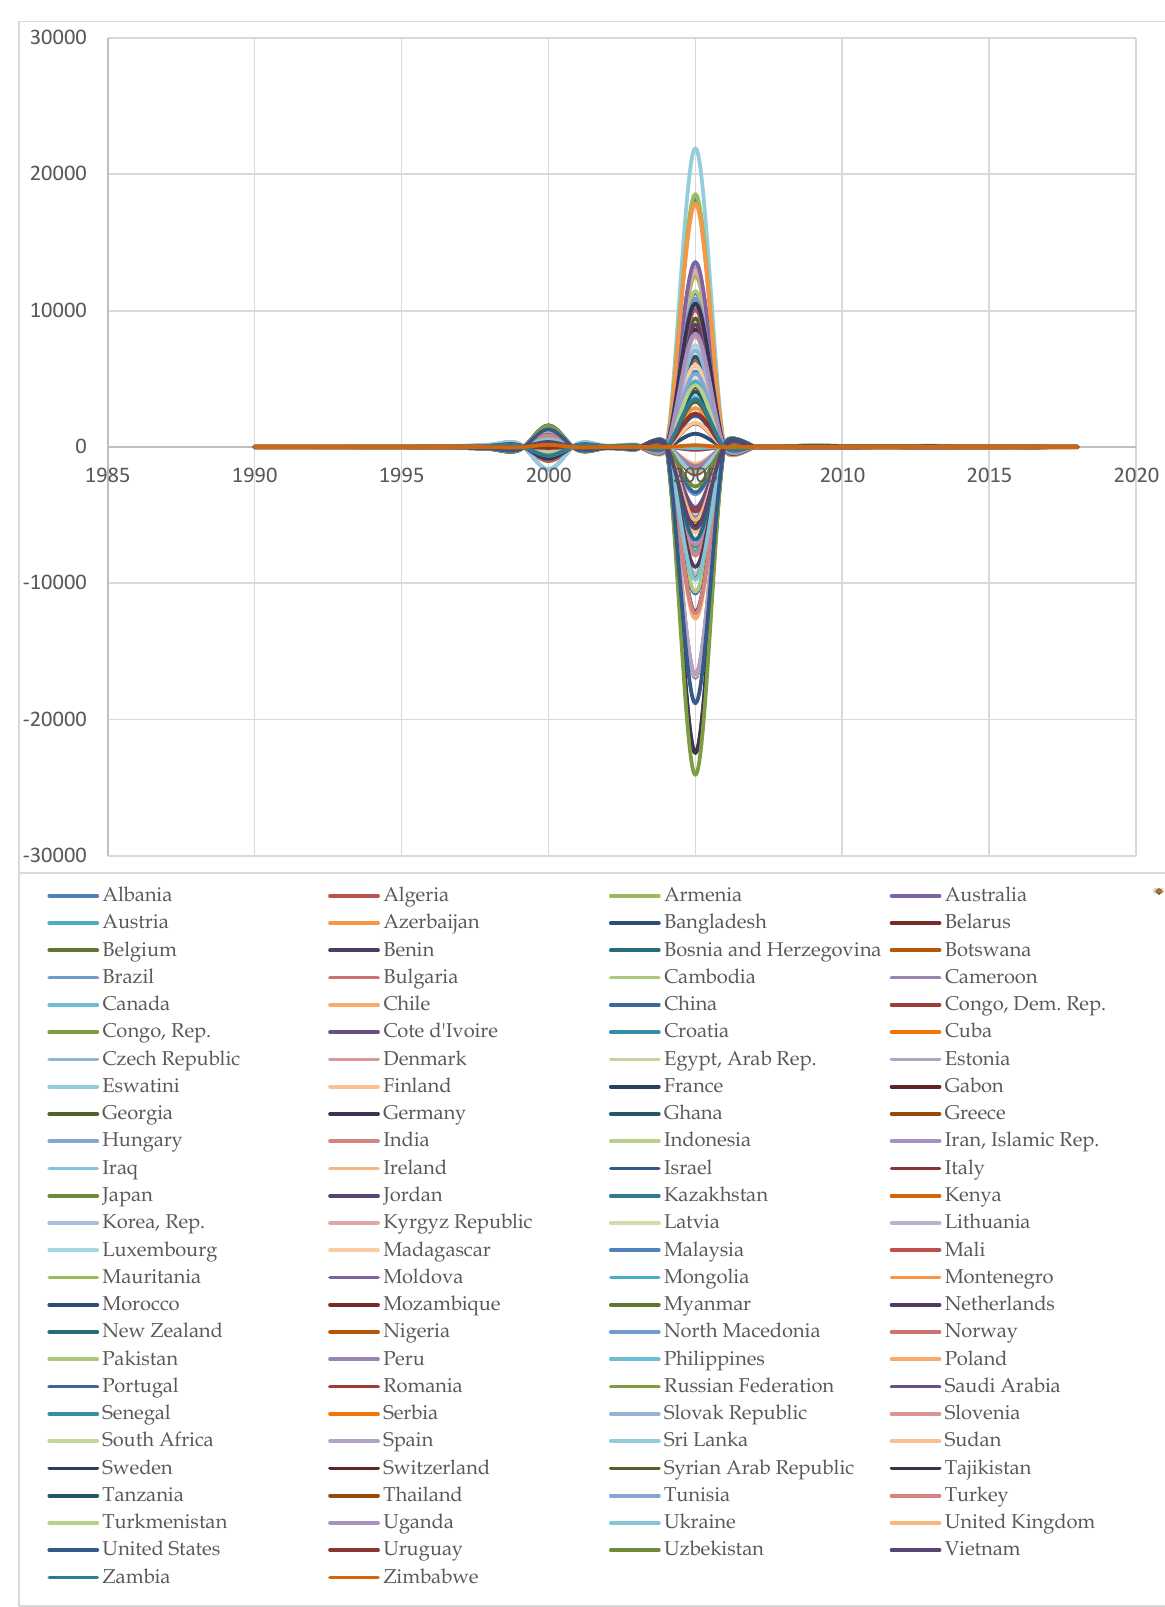
Figure 1. Transportation panel transition paths for the World countries/full